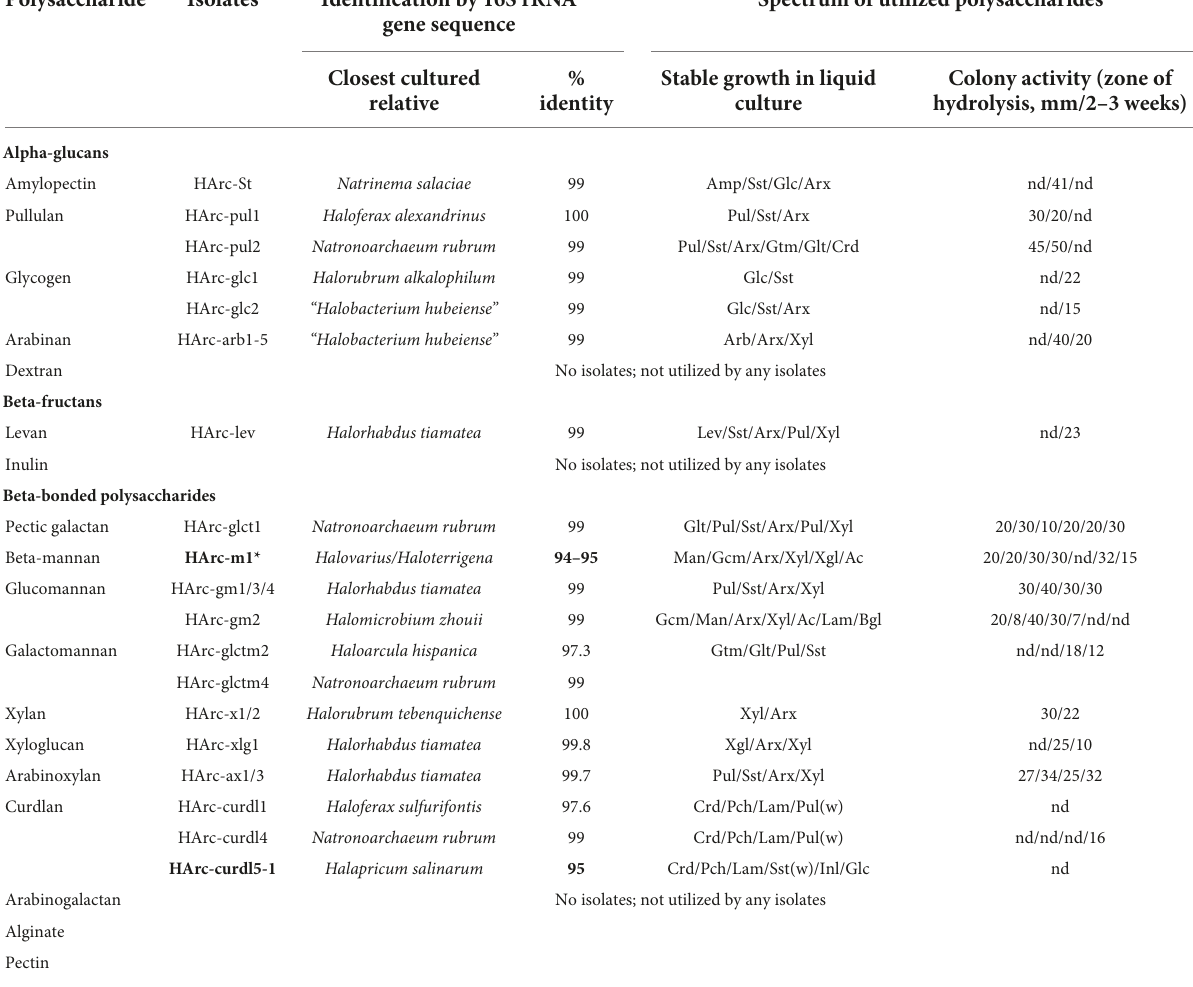
TABLE 1 Polysaccharide-utilizing neutrophilic haloarchaea enriched and isolated from hypersaline salt lakes with neutral pH. Polysaccharide Isolates Identification by 16S rRNA Spectrum of utilized polysaccharides gene sequence Closest cultured % relative